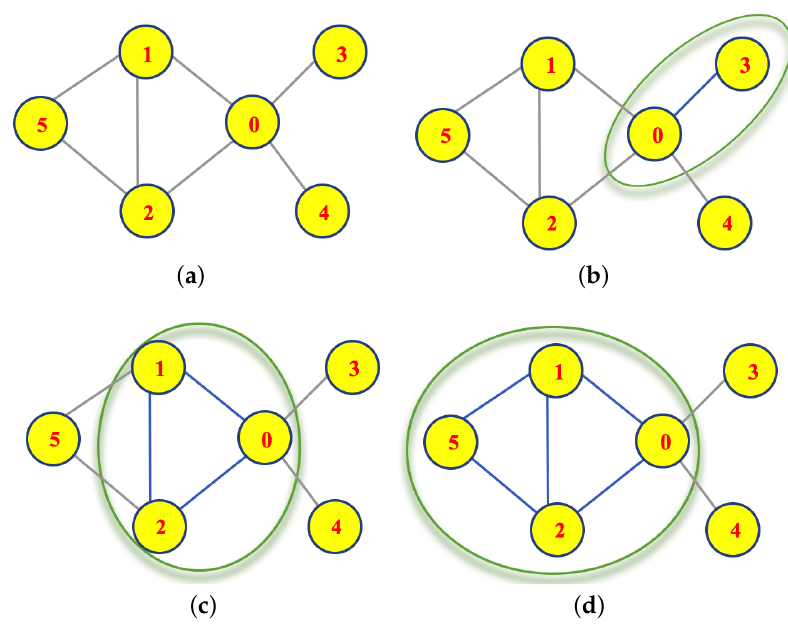
Figure 1. ( a ) A simple graph; ( b – d ) 0.5-quasi-cliques of different sizes containing the node 0: ( b ) an α -quasi-clique of size 2; ( c ) an α -quasi-clique of size 3; ( d ) an α -quasi-clique of size